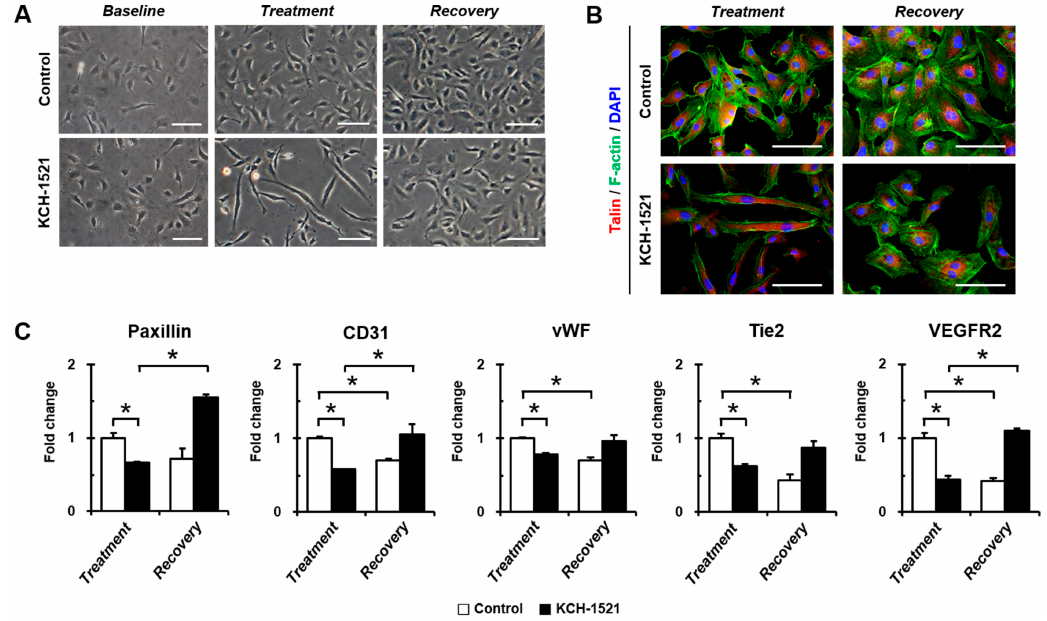
Figure 4. Reversibility of KCH-1521 on HUVECs. ( A ) Representative phase-contrast images indicating cell morphology ( Baseline ), morphological change ( Treatment ) after 24 h of treatment, and reversibility ( Recovery ) after 24 h of KCH-1521 removal compared to the control. Scale bars = 100 µ m; ( B ) representative immunofluorescence images of talin (red) and F-actin (green) in the control and KCH-1521. Nuclei were stained with DAPI (blue). Scale bars = 100 µ m; ( C ) real-time PCR analyses showing recovery of paxillin , CD31 , vWF , Tie2 , and VEGFR2 gene expression at Recovery compared to Treatment in KCH-1521. Data shown represent the mean ± SD of three independent experiments (* p < 0.05). Scale bars in ( A , B ) = 100 µ m.